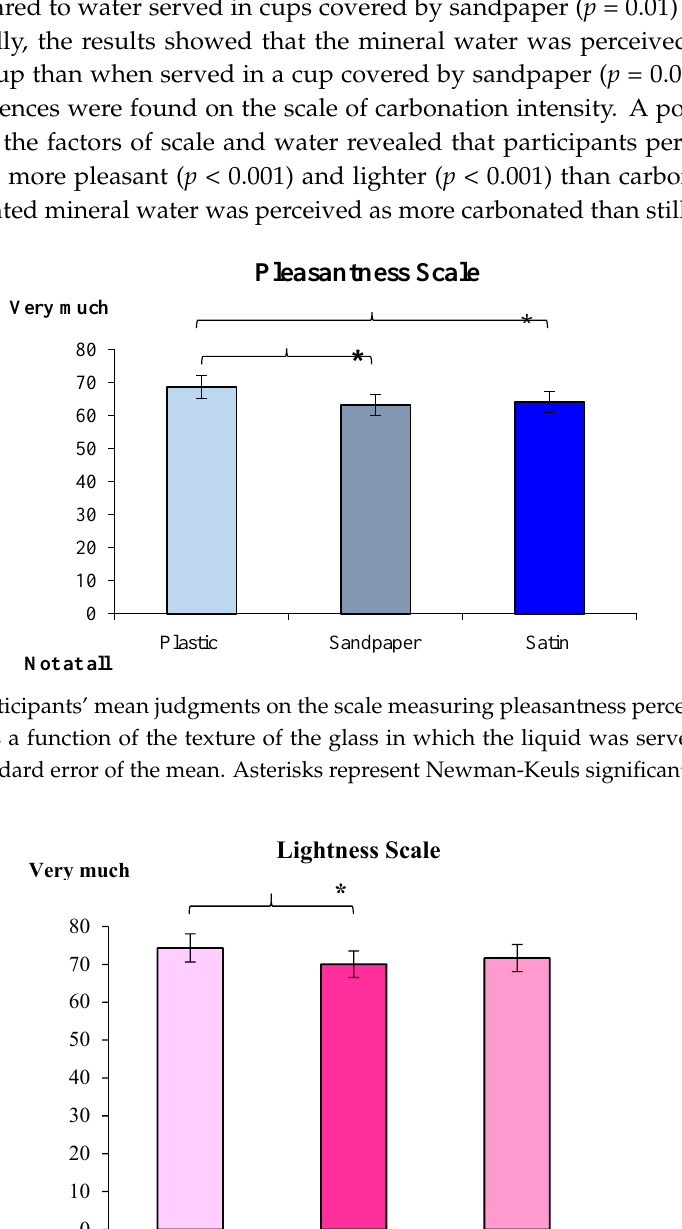
Figure 2. The participants’ mean judgments on the scale measuring freshness perception for both kinds of water as a function of the texture of the glass in which the liquid was served. Error bars represent the standard error of the mean. Asterisks represent Newman–Keuls significant differences at p < 0.05.